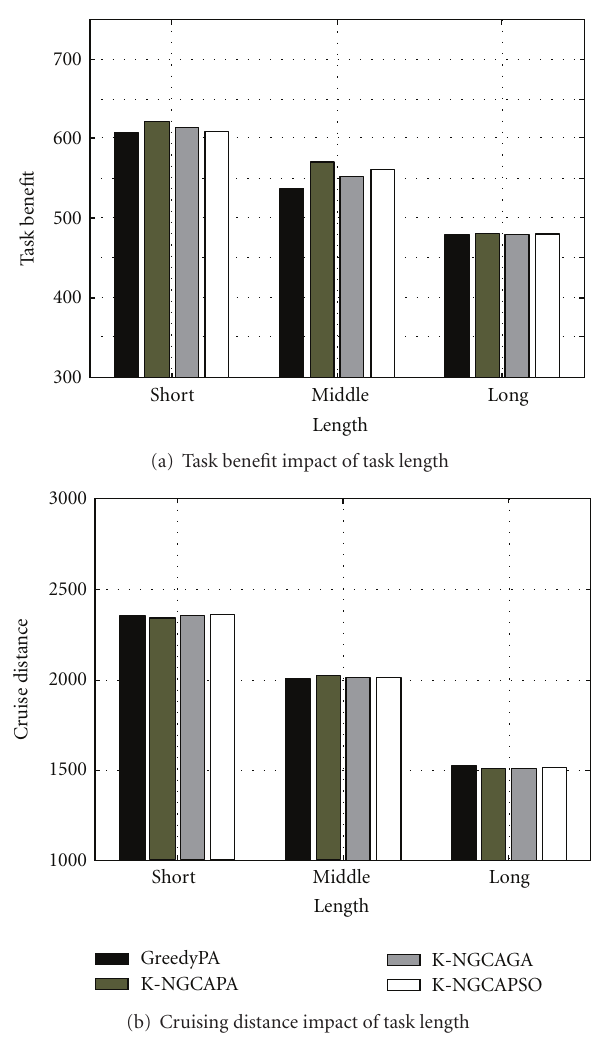
Figure 6: Scheduling results in di ff erent task